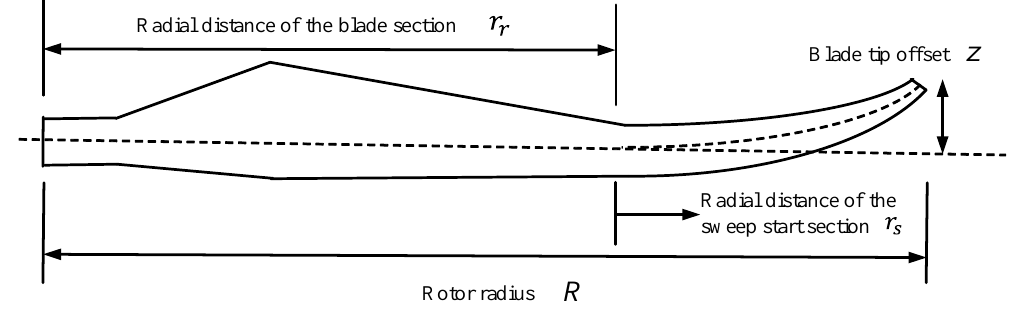
Radial distance of the sweep start section